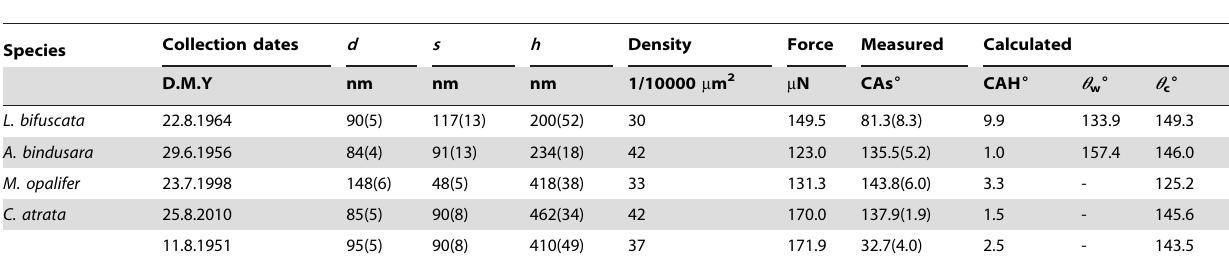
Table 1. Mean values and standard deviations (in brackets) of nanostructure parameters including diameter ( d ), spacing ( s ), height ( h ) and the density of protrusions, the adhesive force, measured contact angles (CAs) and calculated contact angle hysteresis (CAH), h w and h c based on the Wenzel and Cassie-Baxter wetting states on dry wing surfaces of four species of cicadas collected on different dates.